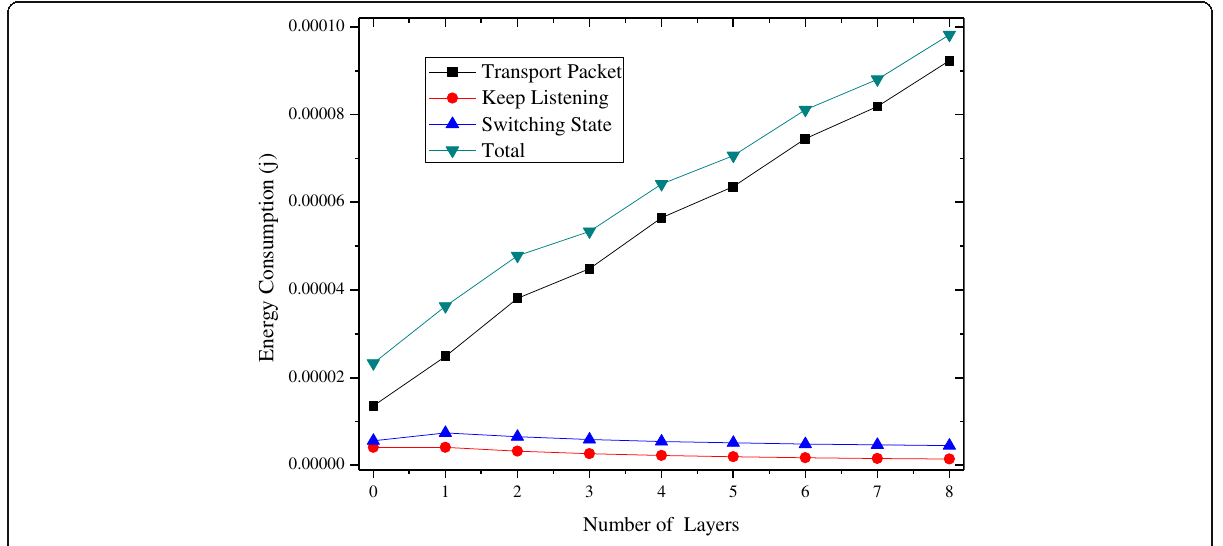
Fig. 13 Different energy consumed by nodes on different